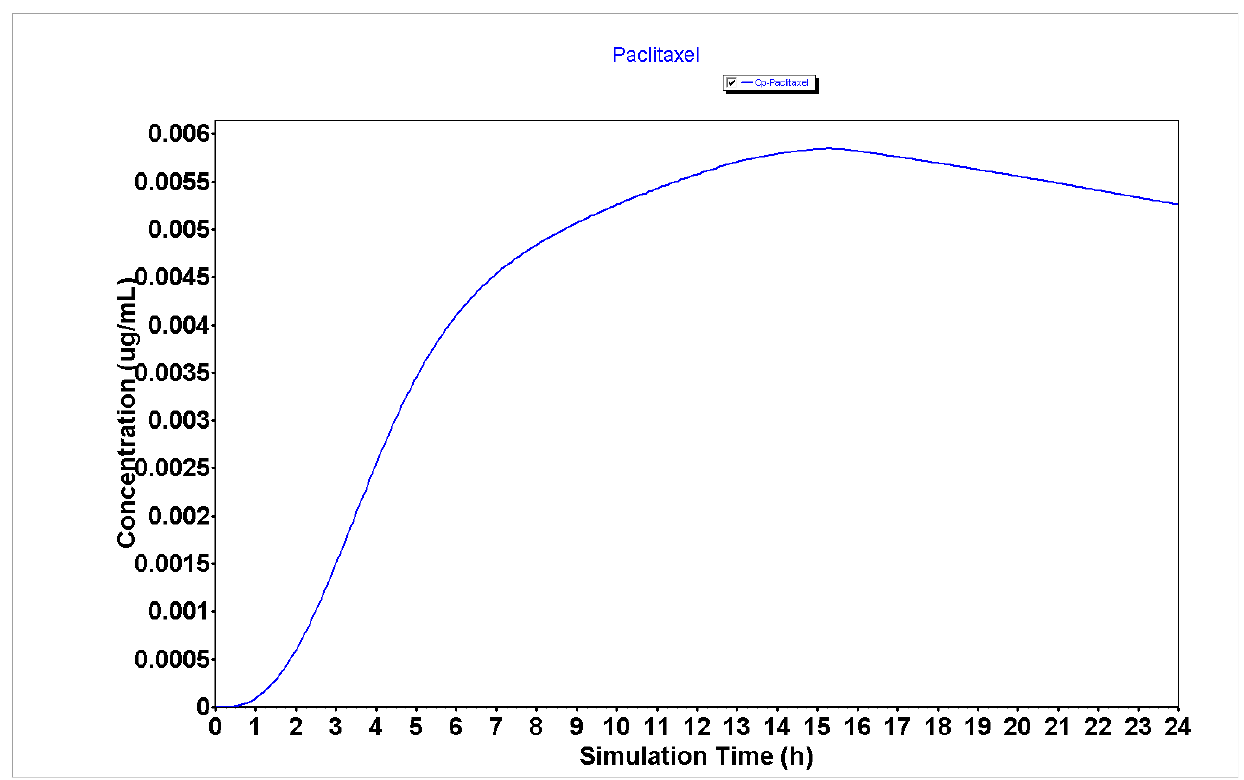
Figure 3. Plasma concentration of PTX generated using the GastroPlus ® software.